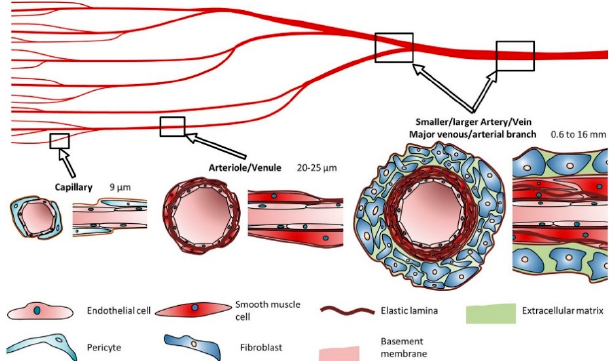
Figure 1. Blood vessels cell types and composition with diameter range. Reprinted by permission from Springer Nature: Nature, Scientific Reports, Reference [21] , © 2018.